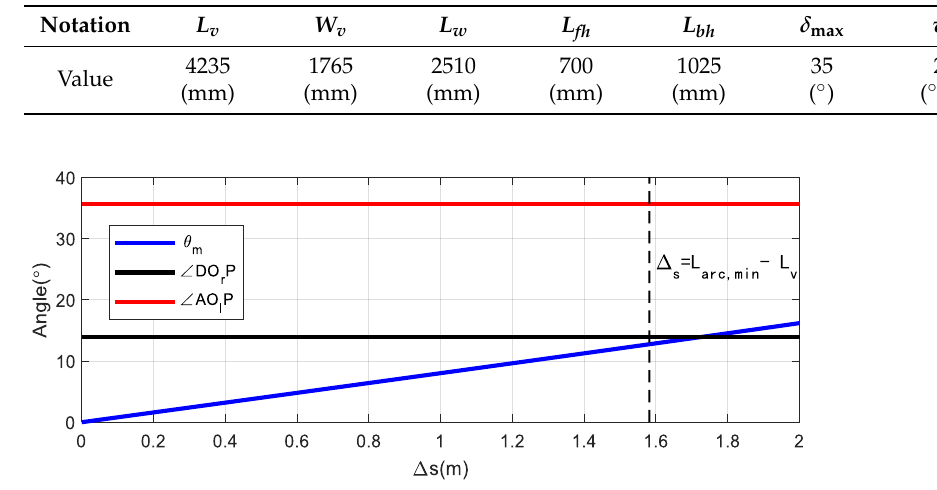
Figure 5. The trend of maximum central angle. Table 1. Parameters of used vehicle model.